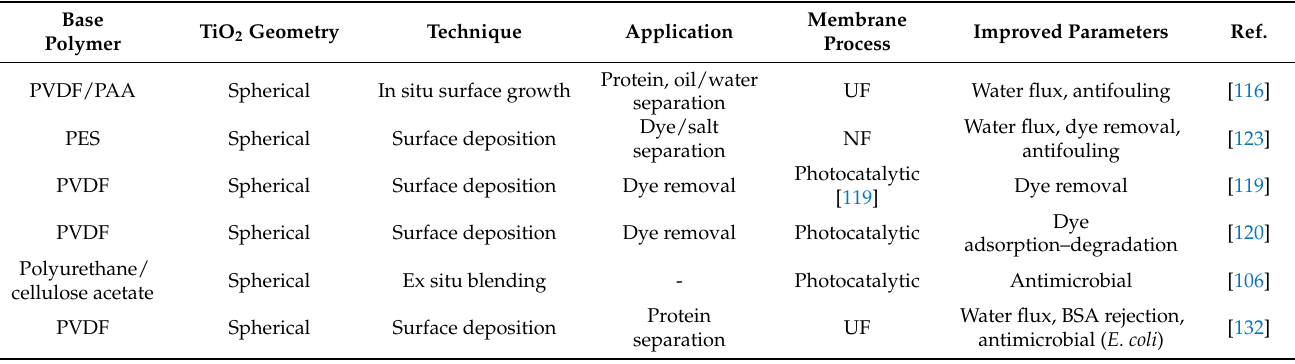
Table 1. Exemplary liquid separation nanocomposite membrane incorporated with multidimensional TiO 2